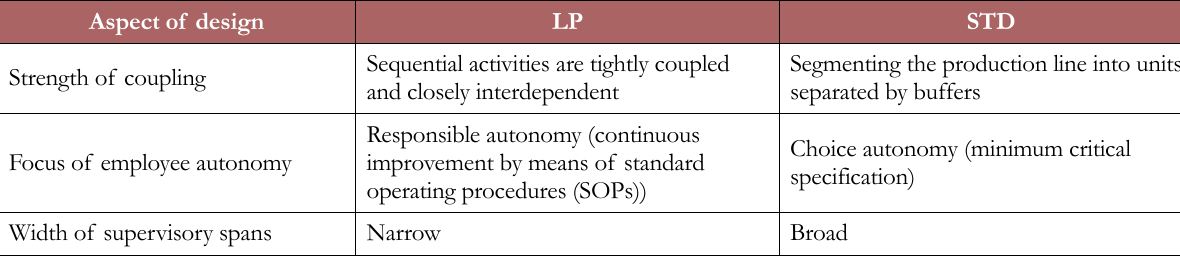
Table 1. Contested issues in the LP–STD